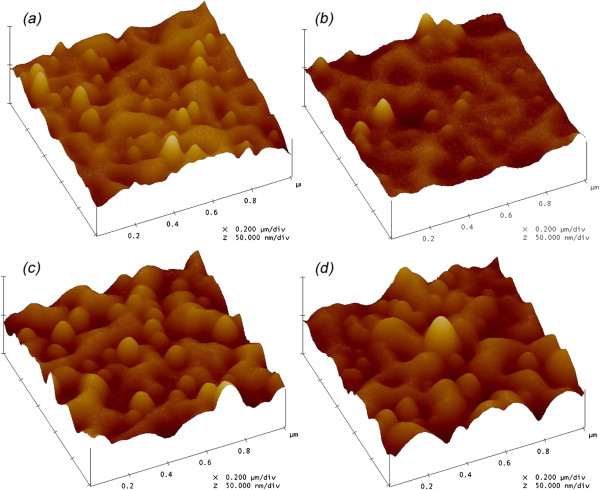
AFM images. (a) Uncoated PET film, the Al2O3-coated PET films by (b) ALD, (c) ALD with plasma pretreatment, and (d) PA-ALD.